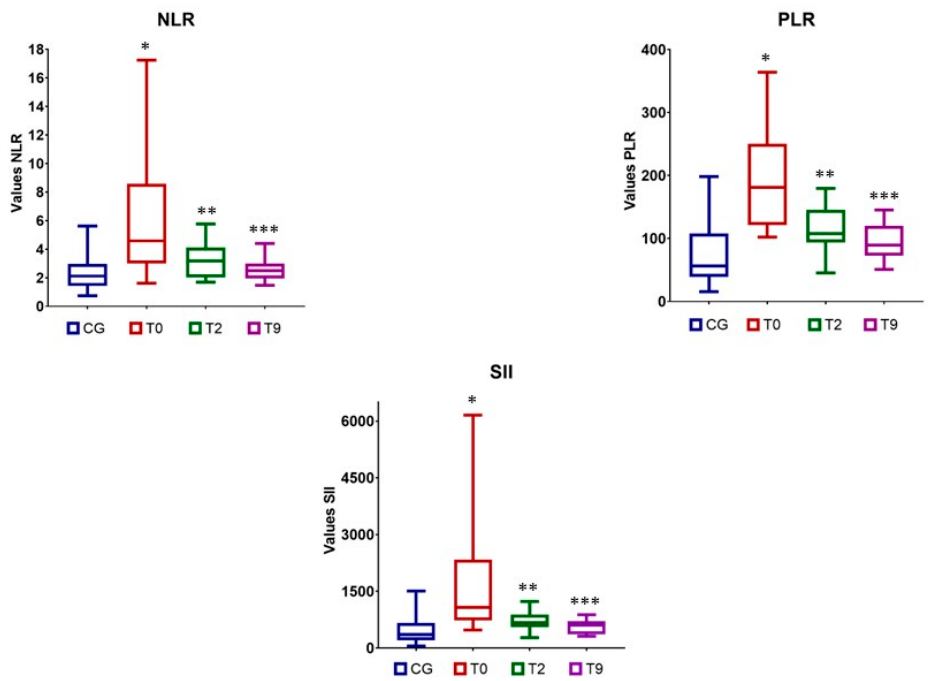
Figure 2. Neutrophil-to-lymphocyte ratio (NLR), platelet-to-lymphocyte ratio (PLR), and systemic immune-inflammation index (SII) in the control group (CG) and in dogs with CIE treated with mesenchymal stem cells at the different time points: before treatment (T0), at 2 months (T2), and at 9 (T9) months after therapy. NLR: * p < 0.0001, effect size (95% CI): 1.29 (0.54; 1.98); ** p = 0.02; effect size (95% CI): 0.66 ( − 0.03; 1.32); *** p = 0.298, effect size (95% CI): 0.14 ( − 0.52; 0.79). PLR: * p < 0.0001, effect size (95% CI): 1.94 (1.11; 2.68); ** p = 0.005; effect size (95% CI): 0.96 (0.24; 1.63); *** p = 0.04; effect size (95% CI):0.52 ( − 0.16; 1.18). SII: * p < 0.0001, effect size (95% CI): 1.28 (0.54; 1.97); ** p = 0.008; effect size (95% CI): 0.76 (0.06; 1.42); *** p = 0.131, effect size (95% CI): 0.27 ( − 0.39; 0.93).